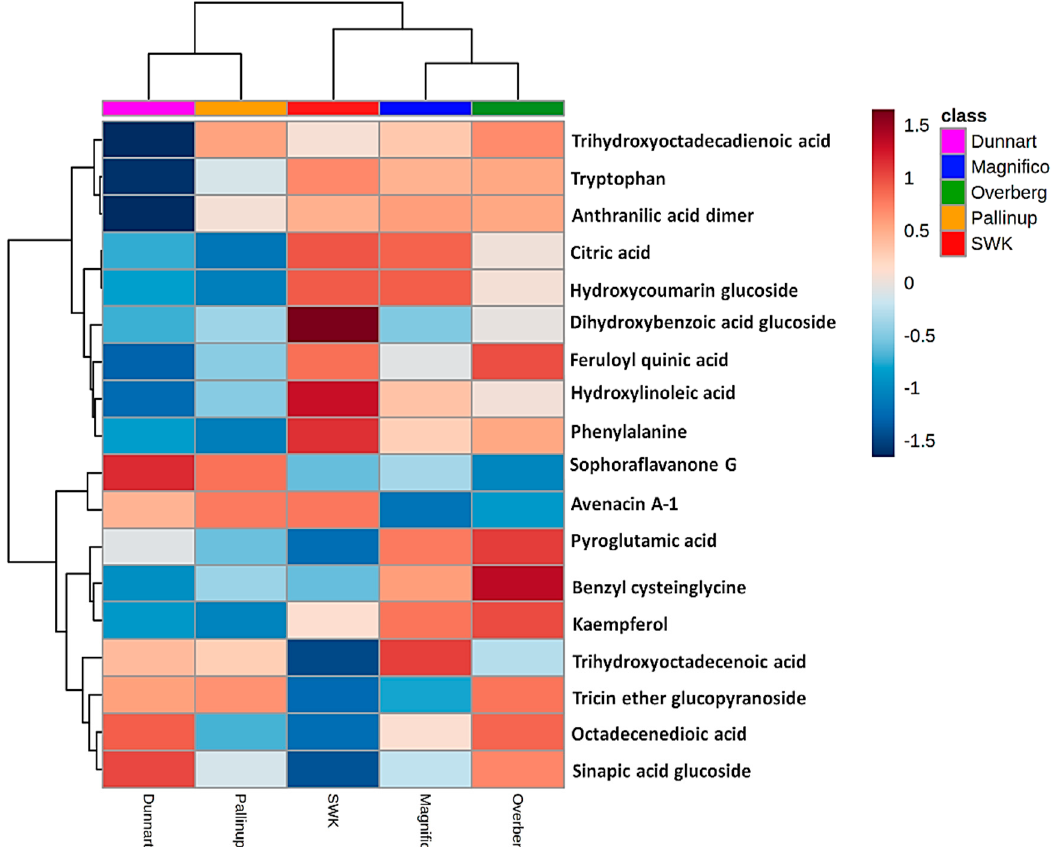
Figure 7. Individual peak intensities of annotated metabolites from oat roots using heatmap analysis (Pearson distance and Ward’s linkage rule) of the five cultivars ‘Overberg’, ‘Pallinup’, ‘Dunnart’, ‘Magnifico’ and ‘SWK001’. The mean peak intensities of each annotated metabolite are shown after Pareto scaling of the data. Values higher than the averages are indicated in red and lower values in blue, with each row representing discriminant features and each column representing the respective cultivars.